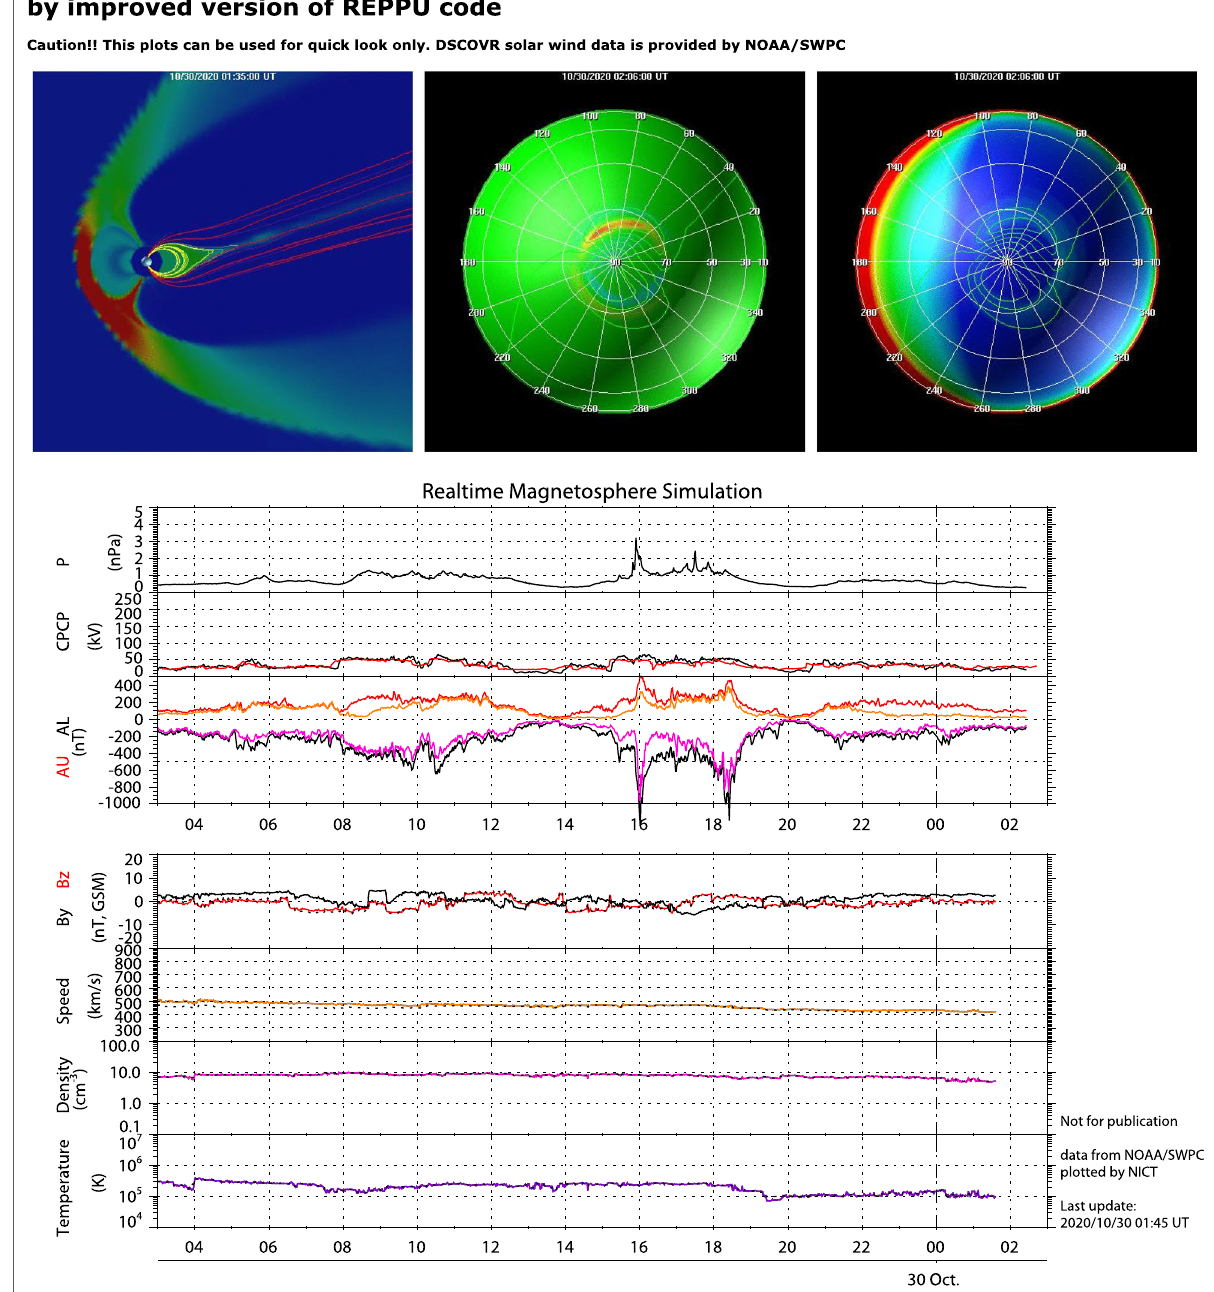
Fig. 2 A screenshot of a web page which shows input parameters and the real‑time global magnetosphere MHD simulation